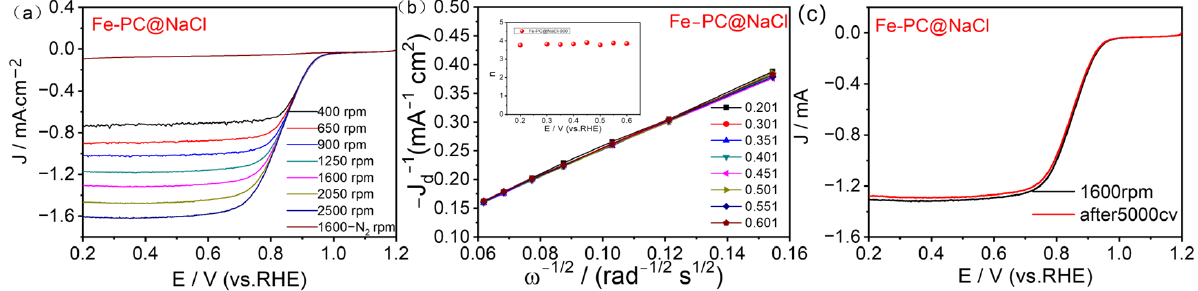
Figure 7. ( a ) LSV curves of Fe-PC@NaCl-900 at various rotation rates. ( b ) K–L plots at various potentials. ( c ) LSV curves of Fe-PC@NaCl-900 before and after cycling for 5000 cycles with 1600 rpm RDE.